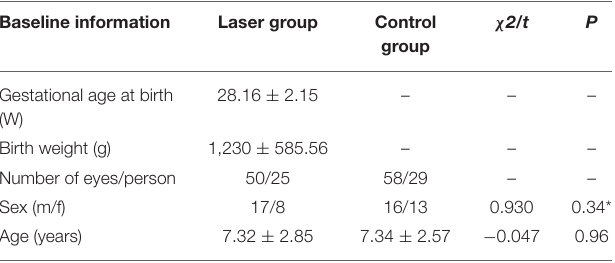
TABLE 1 | Statistical comparisons of baseline information between the laser and control groups. Baseline